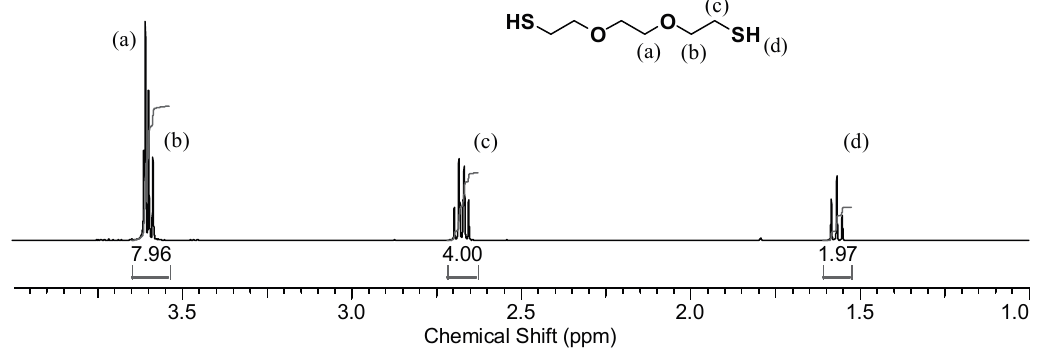
Figure 3. 1 H-NMR spectrum of DODT in CDCl 3 . (500 MHz; CDCl 3 ; 12 s relax; 128 trans).